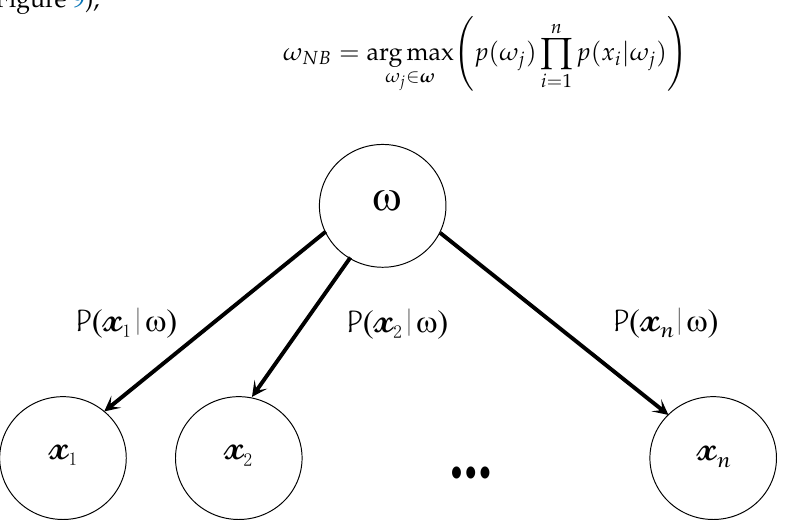
Figure 9. Naïve Bayes model with the assumption of conditional